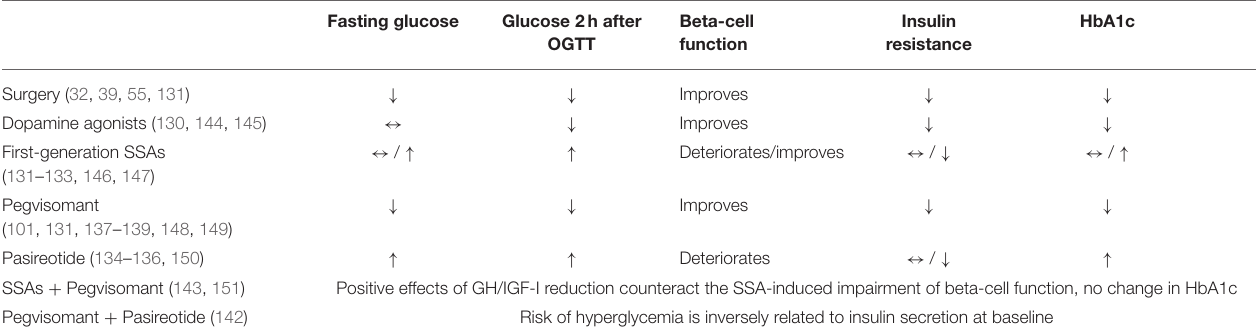
TABLE 1 | Glucose homeostasis in relation to acromegaly treatment options. Fasting